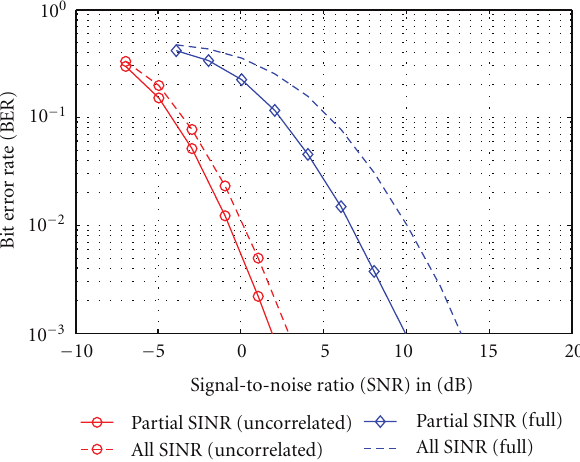
Figure 4: Channel gain at every spatial subchannel (“Full” correla- tion mode).